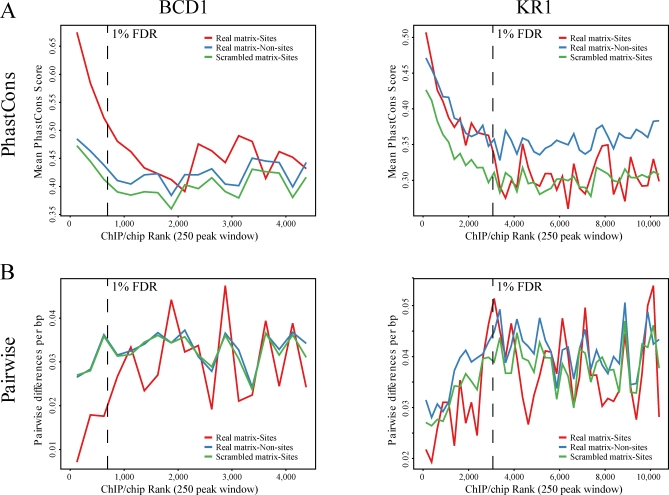
Recognition Sequence Conservation as a Function of Peak IntensityConservation scores in predicted factor recognition sequences (p-value ≤ 0.001) (red lines), all remaining sequences (blue lines), and in sequences matching scrambled variants of the factors' recognition sequences (p-value ≤ 0.001) (green lines) in the 500-bp regions (±250 bp) around BCD1 and KR1 1% FDR peaks, in nonoverlapping windows of 250 peaks down the rank list to the 25% FDR cutoff. Panels in row (A) shows the mean PhastCons scores, and panels in row (B) the average pairwise differences per base pair between D. melanogaster and D. simulans. Gaps are ignored in the pairwise analysis. The 1% FDR cutoff is indicated by a vertical dotted line.